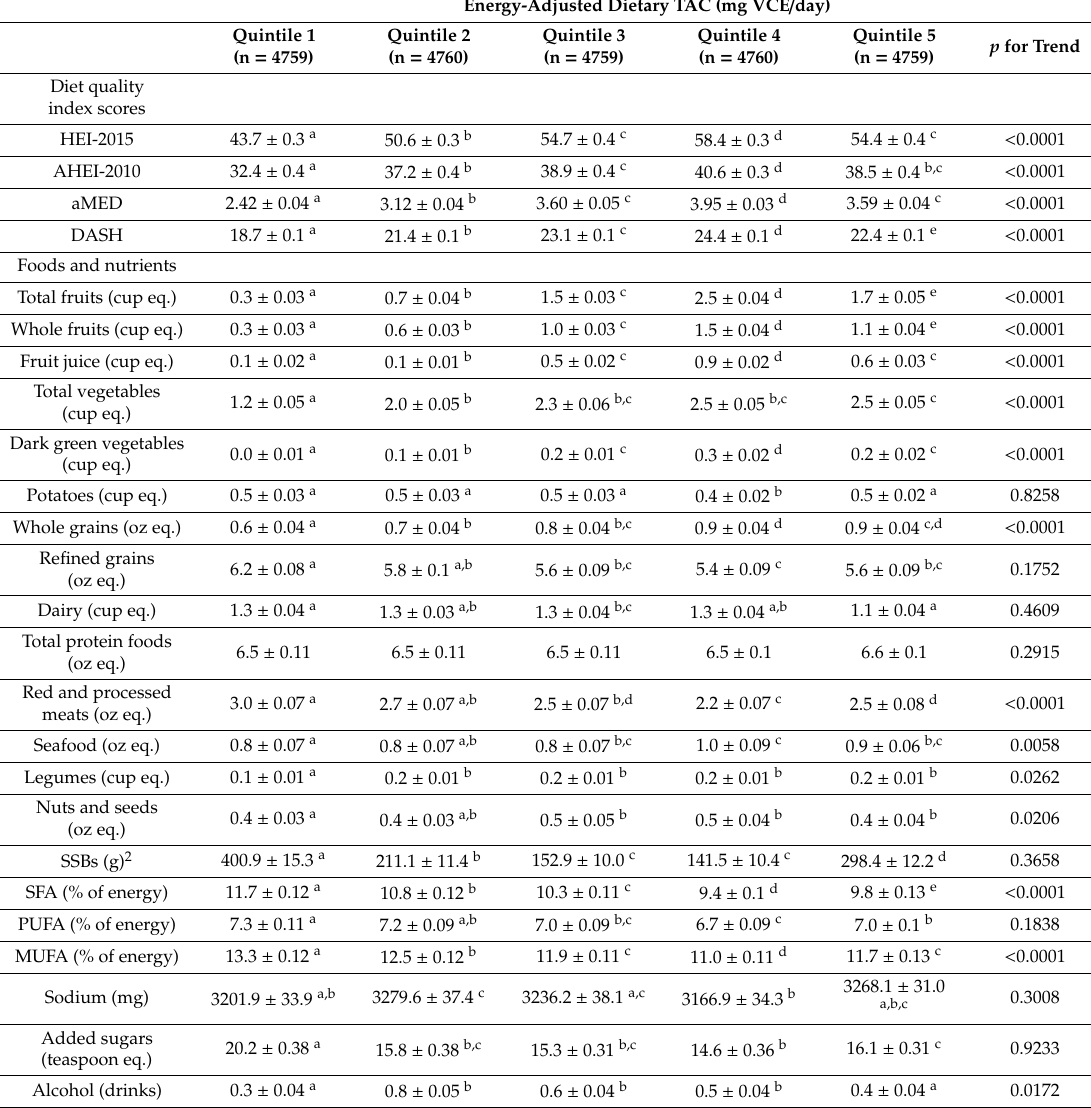
Table 2. Daily food and nutrient intakes and diet quality index scores according to quintile of dietary total antioxidant capacity 1